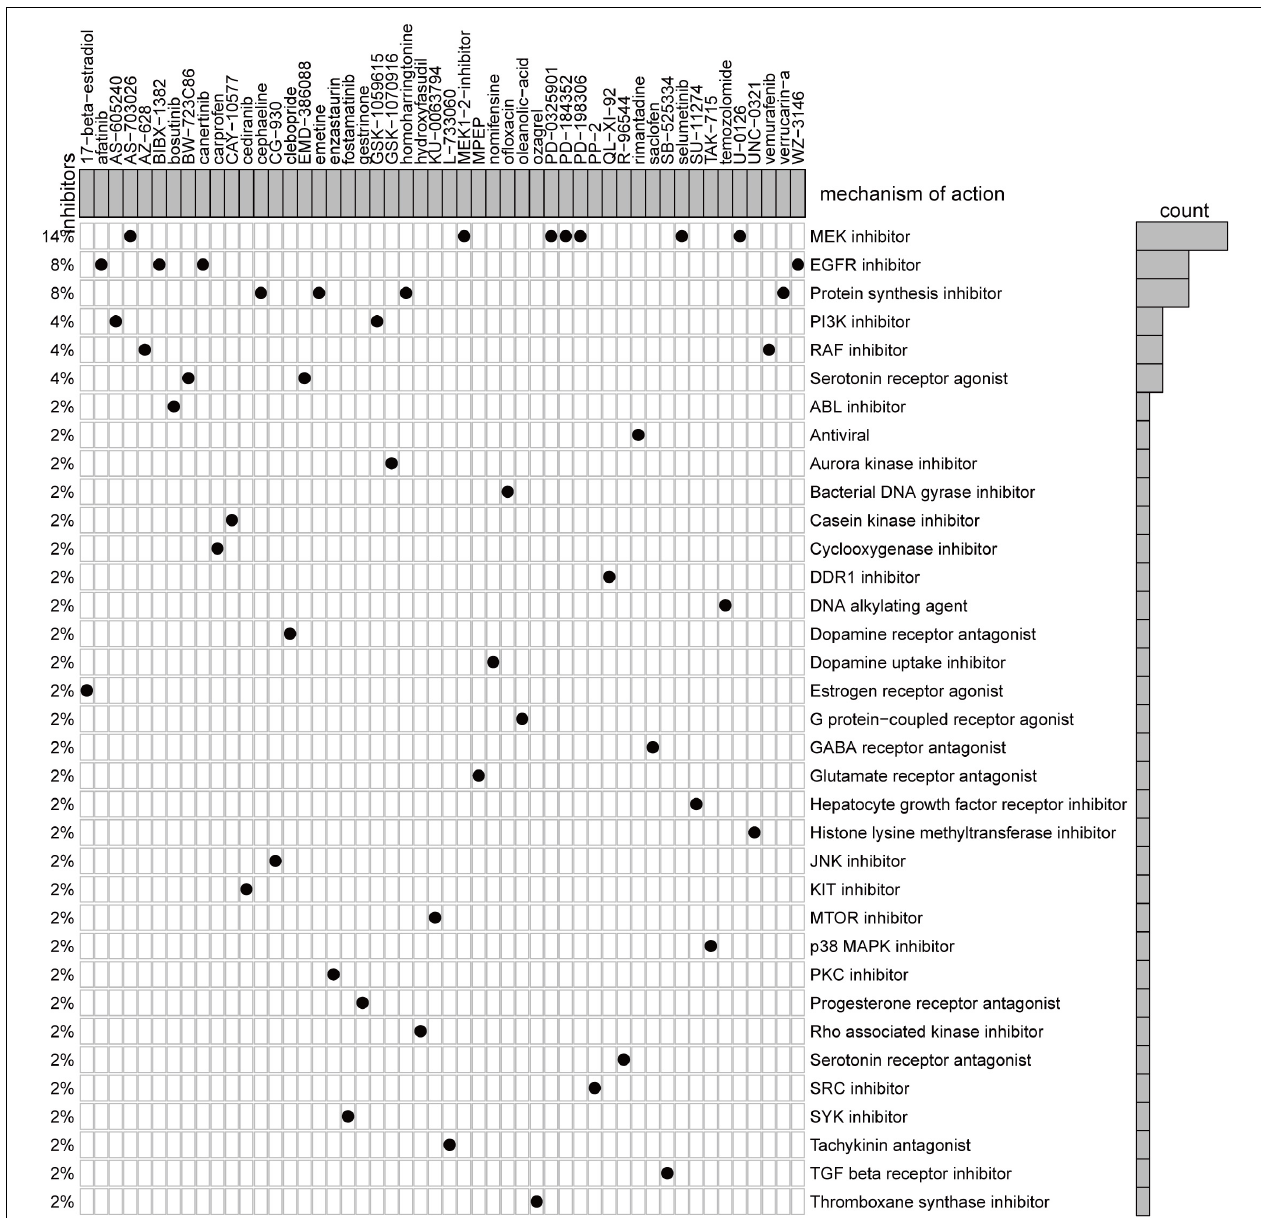
FIGURE 6 | Heatmap showing each compound from the CMap that shares mechanisms of action (rows) and sorted by descending number of compounds with shared mechanisms of